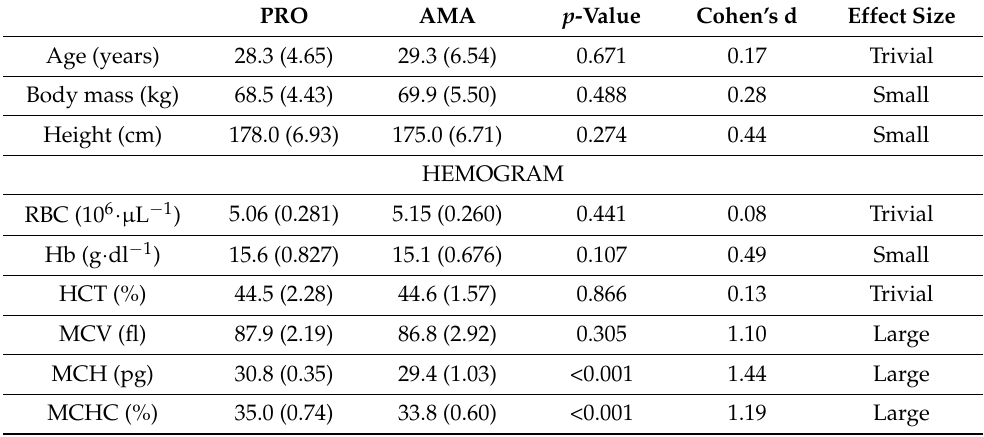
Table 1. Baseline general characteristics and hemogram variables of professional and amateur cyclists.